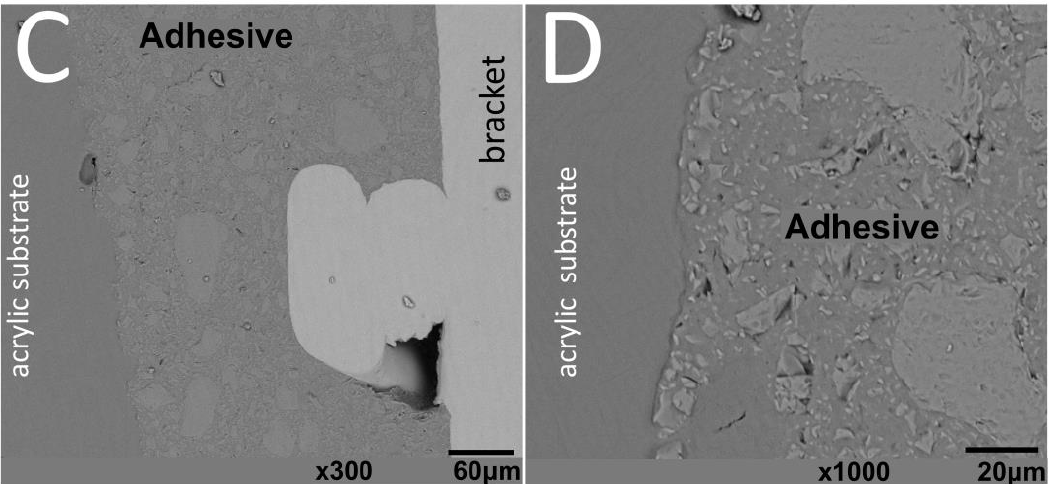
Figure 4. SEM images of metallic brackets bonded to ( A , B ) glass–ceramic or ( C , D ) acrylic surfaces.